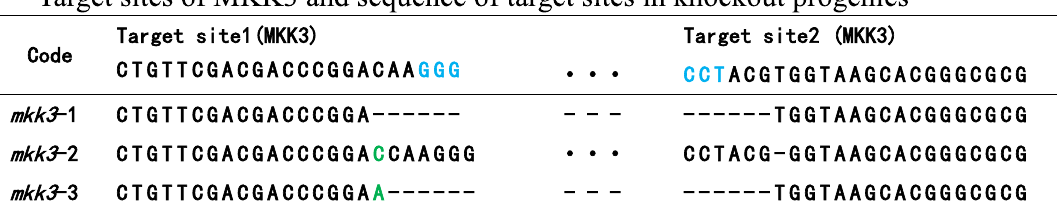
Table 2 Target sites of MKK3 and sequence of target sites in knockout